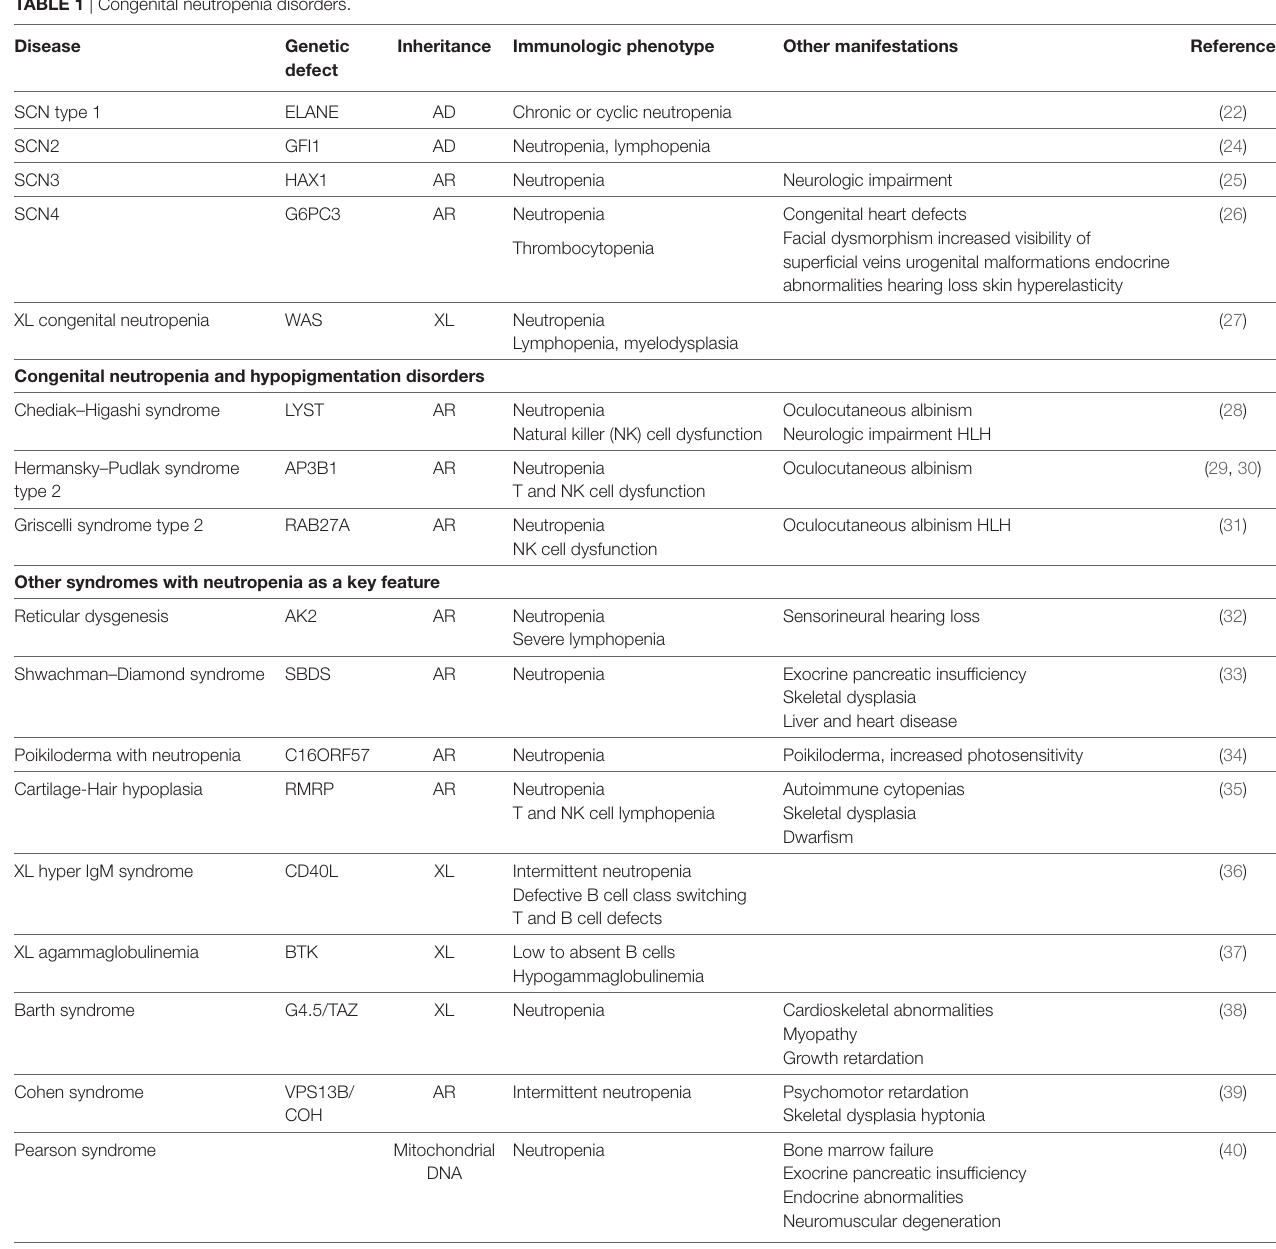
TABLe 1 | Congenital neutropenia